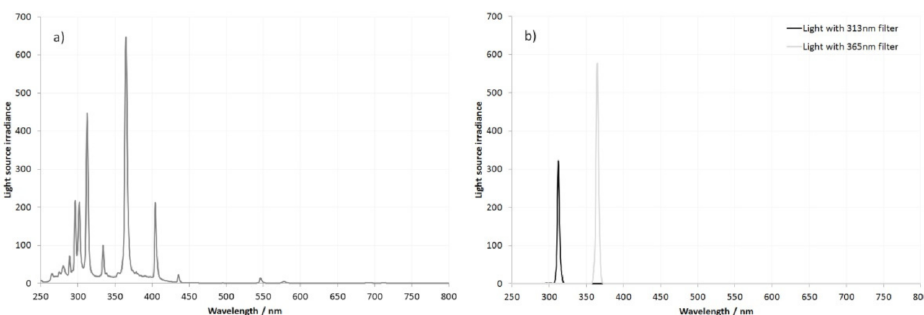
Figure 3. Irradiance spectra of the light source used for the exposure tests at 313 and 365 nm, ( a ) without filtering and ( b ) in combination with the 313 and 365 nm